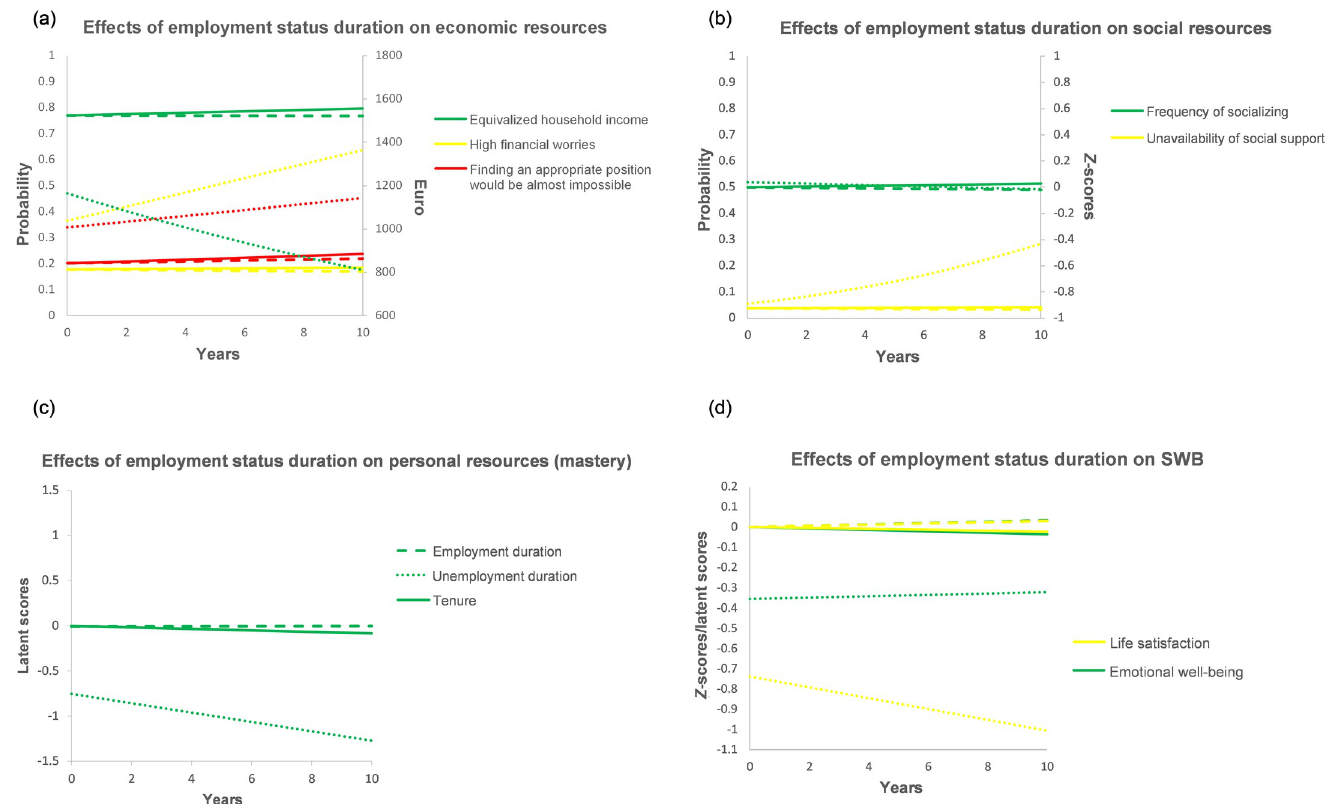
Fig 2. Effects of employment status duration on the change in resources and SWB. Dashed lines = effects of employment duration. Solid lines = effects of organizational tenure. Dotted lines = effects of unemployment duration. The zero point of the X-axis represents not the beginning of an (un)employment spell or of time with the firm but its person-specific